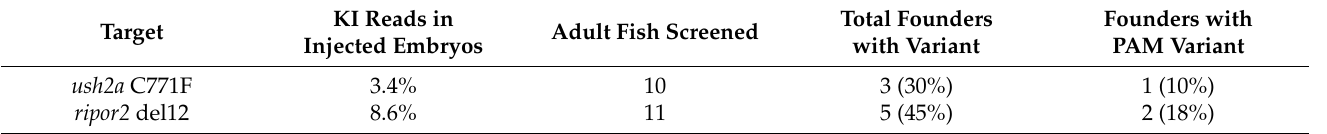
Table 1. Somatic knock-in efficiency and subsequent germline